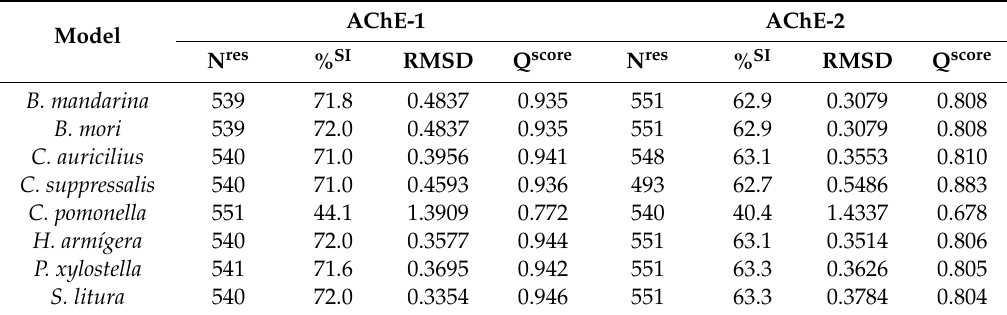
Table 1. Alignment results (performed with PDBeFOLD web server [29]). N res , number of aligned residues; % SI , % Sequence Identity; root-mean-square deviation (RMSD); quality of alignment (Q score) , with 1 being the highest score. Model